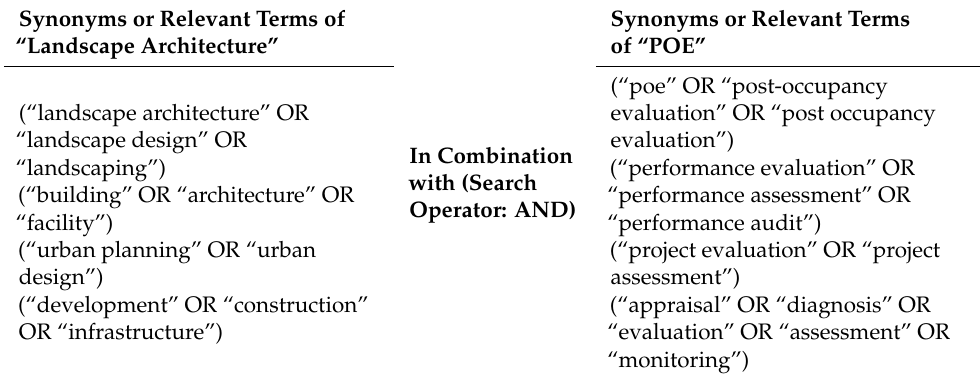
Table 1. Synonyms or relevant terms of “Landscape architecture” and “POE” were combined as the keywords for